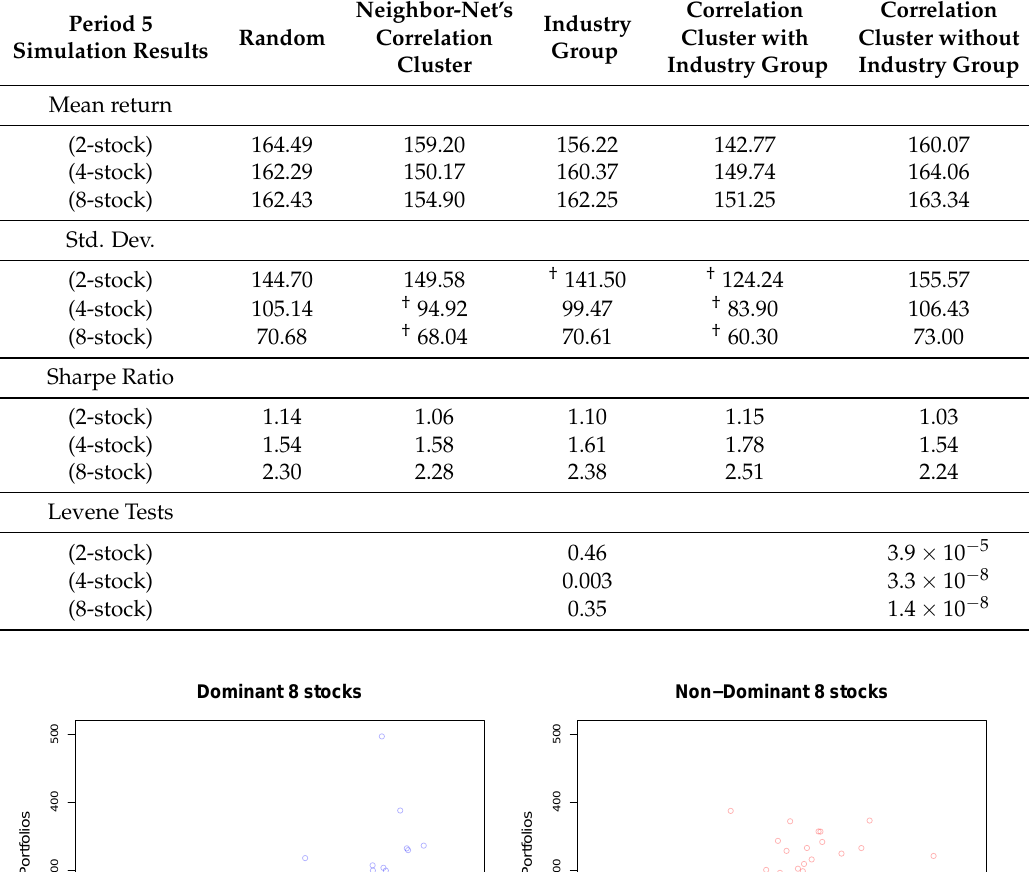
Table 5. Period 5 portfolio performances with standard deviation for three different portfolio sizes.